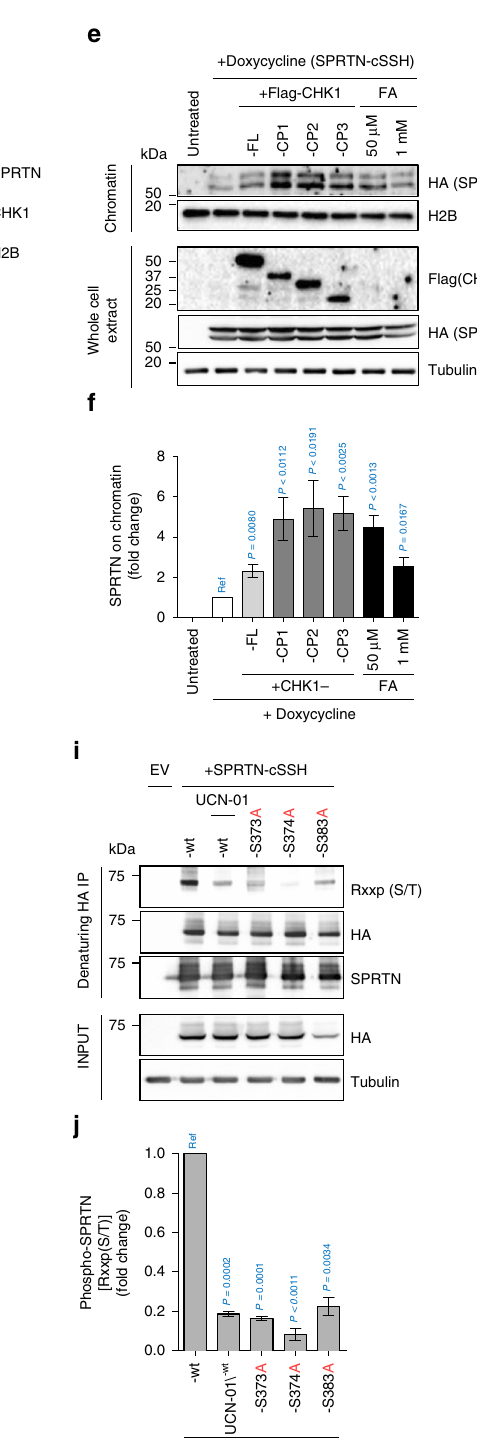
CHK1 phosphorylates the C-terminal regulatory part of SPRTN . To identify CHK1 phosphorylation sites on SPRTN in vivo, we performed mass spectrometry. SPRTN-E112A-SSH was ectopically expressed in HEK293 cells co-transfected with either CHK1-wt or the kinase-defective CHK1-S345A, and anti- SSH precipitates were isolated under denaturing conditions (Fig. 6g and Supplementary Fig. 7a). The SPRTN-E112A protease dead mutant was used to avoid auto-cleavage activity 25 (Fig. 5a, lower panel). Mass spectrometry analysis identi fi ed three main